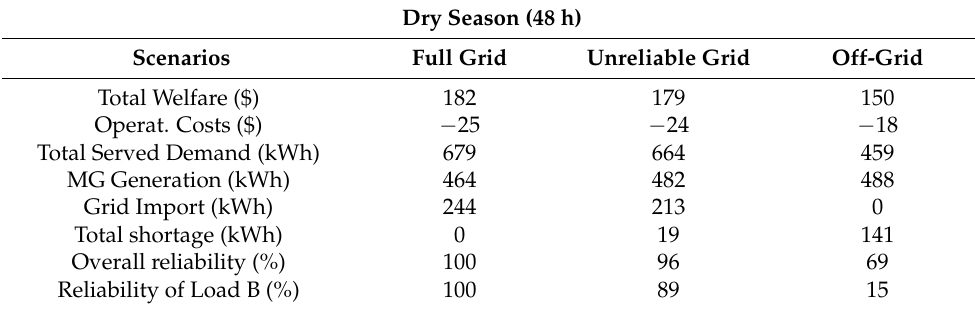
Table 1. Result Summary Table for Scenarios in the Dry Season.